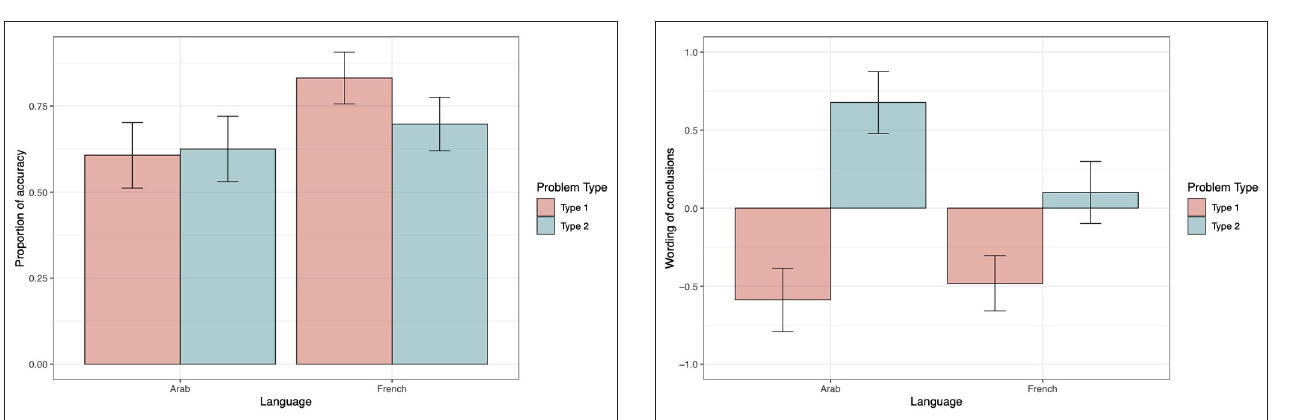
FIGURE 1 | Accuracy as a function of Problem type and Language. The within-subjects 95% confidence intervals were computed following the method proposed by Morey (2008) and were implemented using the R functions developed by Chang (2018). more accurate when confronted to type 1 than type 2 problems.